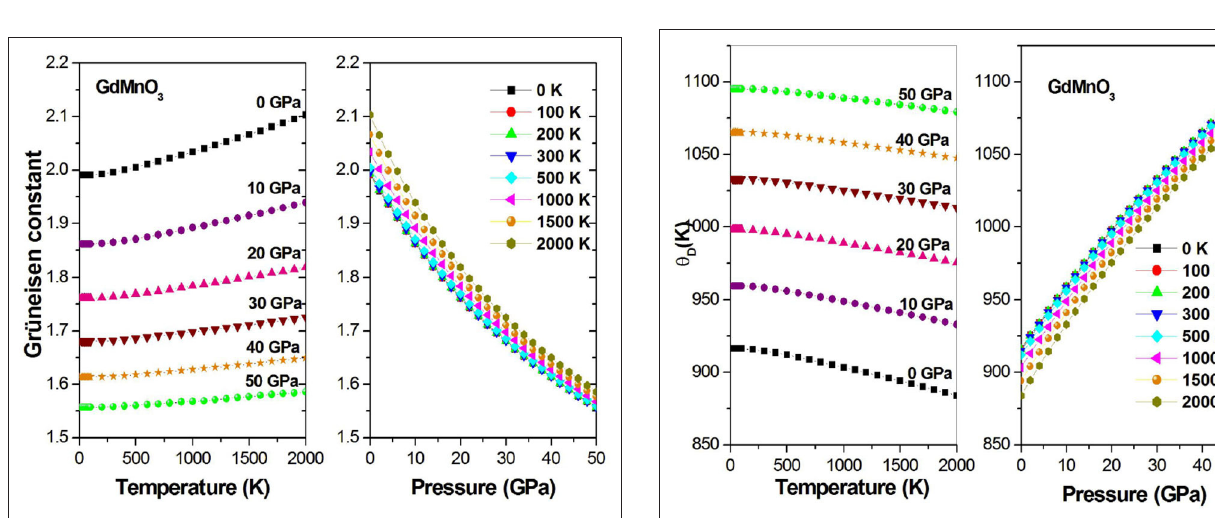
FIGURE 11 | Debye temperature θ p as a function of the temperature (pressure) at different given pressures